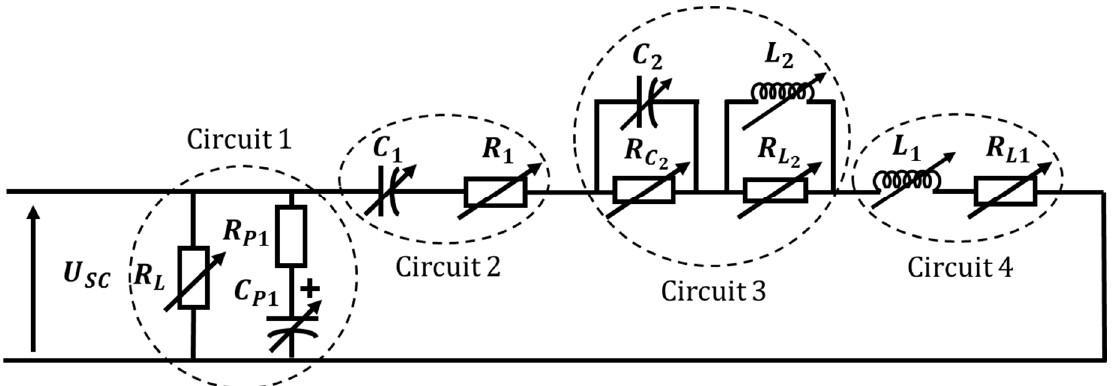
Figure 14. Equivalent electrical circuit to model two SCs connected in series with parameters in function of the voltage in the SC.